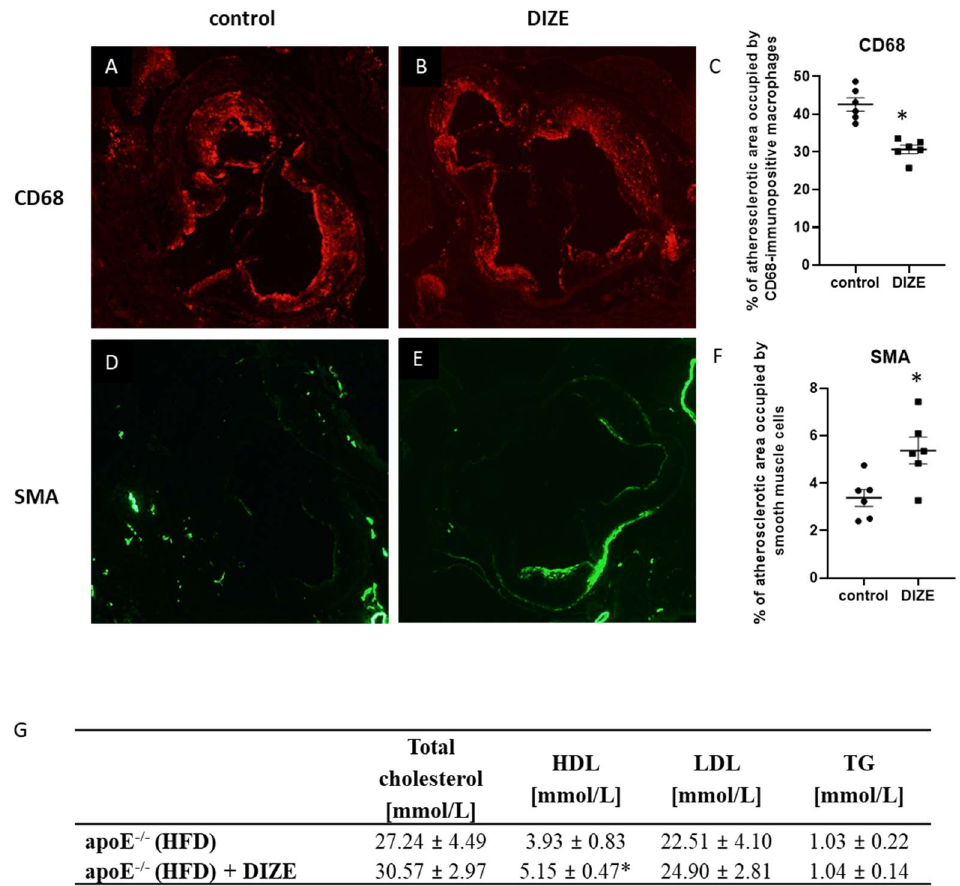
Figure 2. Impact of DIZE on the stability of atherosclerotic plaques. Immunohistochemical staining of aortic roots showing CD68-positive macrophages ( A , B ) and smooth muscle α -actin (SMA) ( D , E ) in control and DIZE-treated mice. Quantitative analysis of the atherosclerotic lesions area occupied by CD68-positive macrophages ( C ) and smooth muscle cells ( F ). The plasma levels of total cholesterol, high-density lipoproteins (HDL), low-density lipoproteins (LDL), and triglycerides (TG) ( G ) in control and DIZE-treated mice. Data are mean ± SEM analyzed using t -test (* p < 0.05 as compared to control mice; n = 4 or 6 per group).